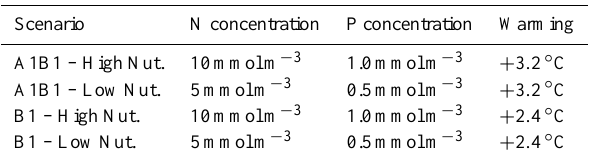
Table 2. The four parameter settings for the long-term coupled ERSEM EwE model, based on year 2100 IPCC climate change sce-